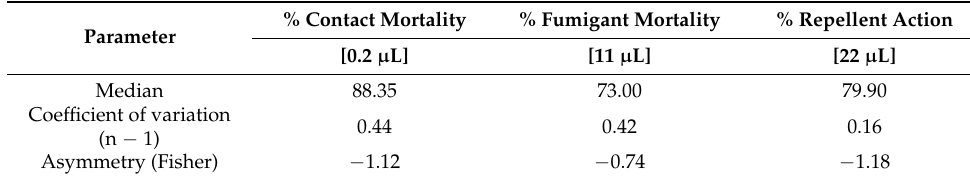
Table 2. Statistical parameters of cluster analysis.